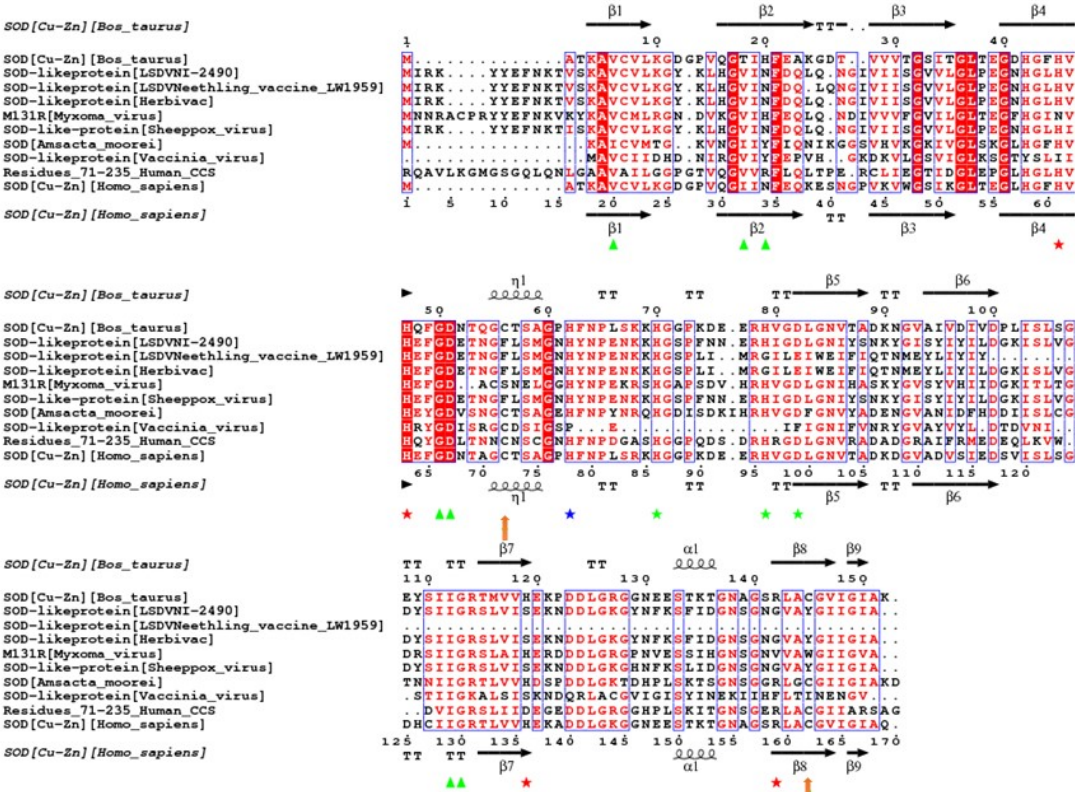
Figure 1. Structural alignment of selected superoxide dismutase (SOD) homologues relative to the bovine Bos taurus SOD amino acid sequence. Alignment of putative SOD-like proteins from lumpy skin disease virus (LSDV) (Neethling Nl 2490 (virulent), Neethling vaccines LW 1959 and Herbivac), with those of bovine SOD, myxoma virus, sheeppox virus, Amsacta moorei entomopoxvirus, vaccinia virus, human CCS (residues 71–235) and human SOD. The structural elements for bovine and human SOD were obtained from the protein databank (1SOS and 1EQ9). SOD alignment was done using the TCoffee Expresso program available on the TCoffee server. Structural alignment was done on ESPript 3.0 Server [29]. Residues of interest: green triangles = residues involved in dimer formation; red asterisks = copper binding residues; green asterisks = zinc binding residues; blue asterisks = residues coordinating the two metal ions; orange arrows = cysteine residues forming disulfide bridge; squiggles = α -helix and 310 helix; arrows = β -strands; TT = strict β -turns; TTT = strict α -turns.